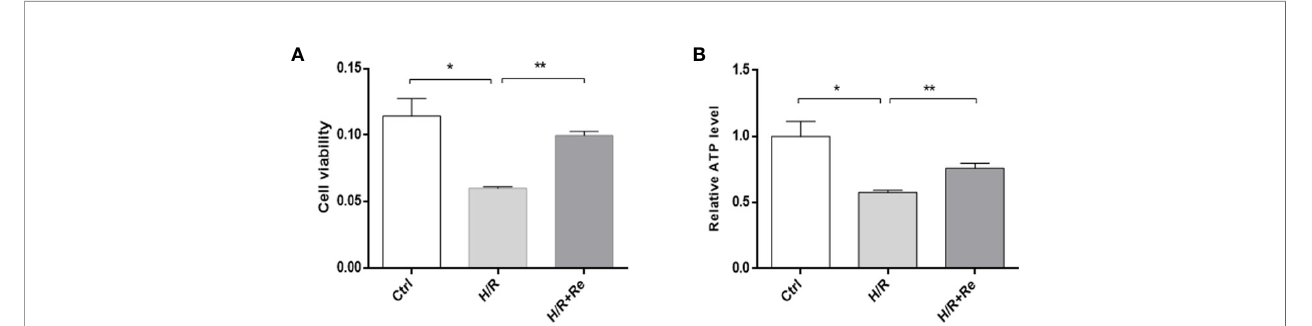
FIGURE 1 | HL-1 cells viability and ATP level after H/R. (A) HL-1 cells viability (n=5). (B) ATP levels (n = 5). All data are shown as mean ± SEM, * P < 0.05, ** P < 0.01. Ctrl, control; H/R, hypoxia reoxygenation; RE, ginsenoside Re; ATP, adenosine